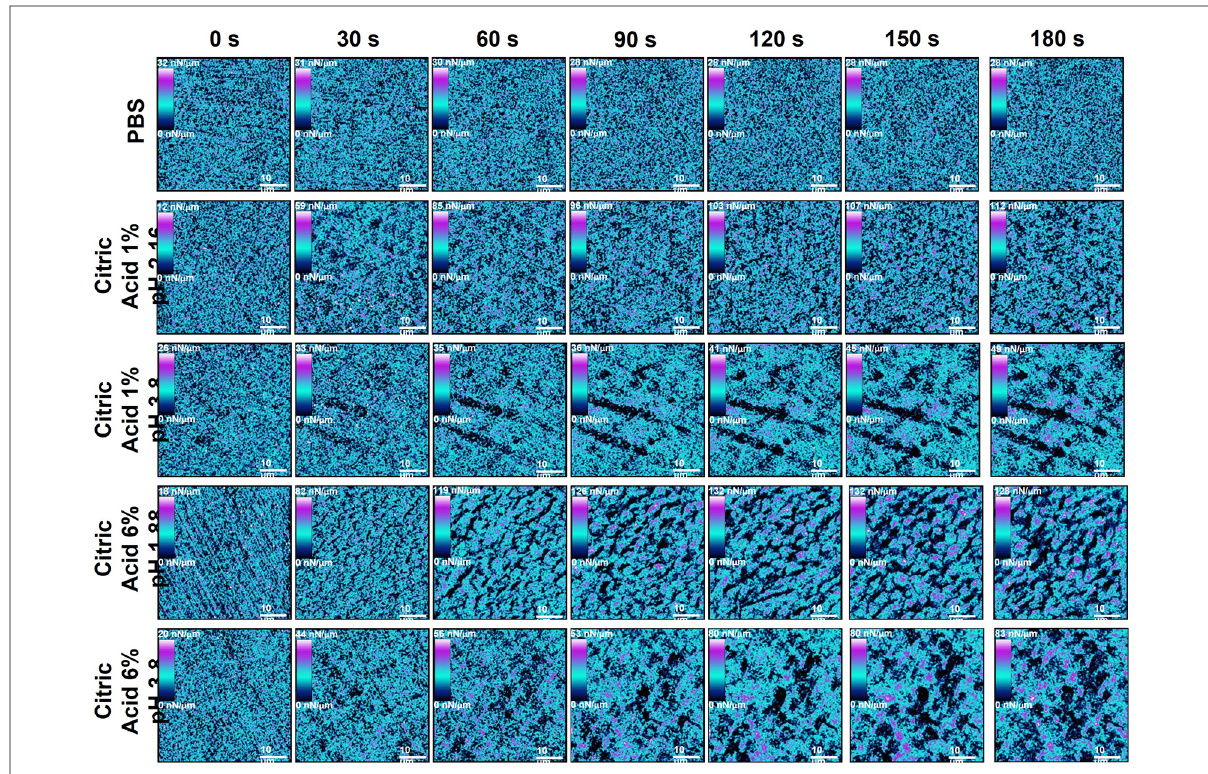
FIGURE 2 Showing example stiffness AFM mapping of human enamel exposed to all dietary solutions (top) throughout the exposure regime starting from 0 s (top) to 180 s (bottom) at 30 s